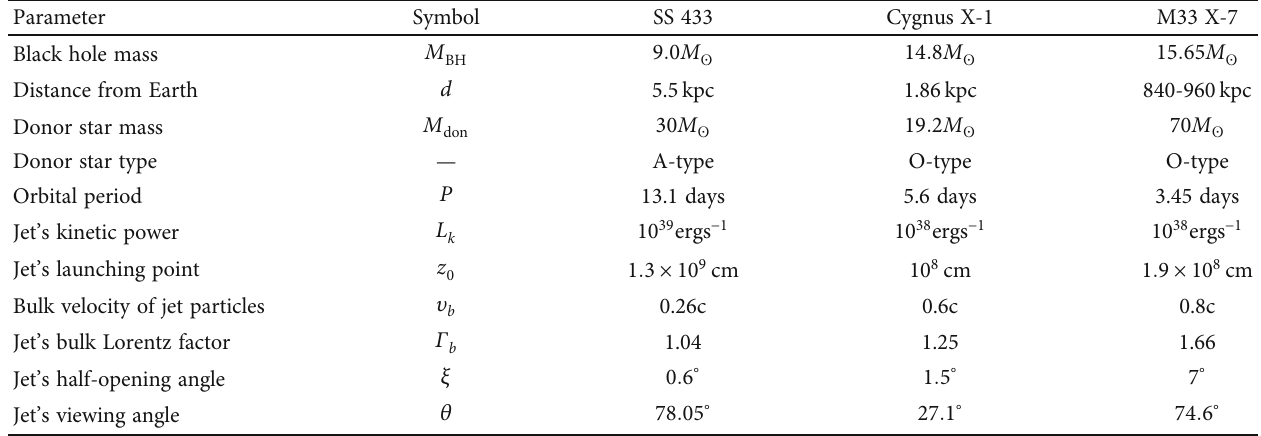
Table 1: Parameters of the model for M33 X-7, Cygnus X-1, and SS